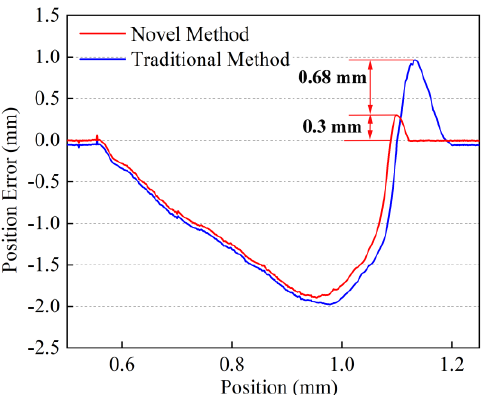
Figure 13. Position errors of the two methods between the two-module under the external disturb- ance condition.